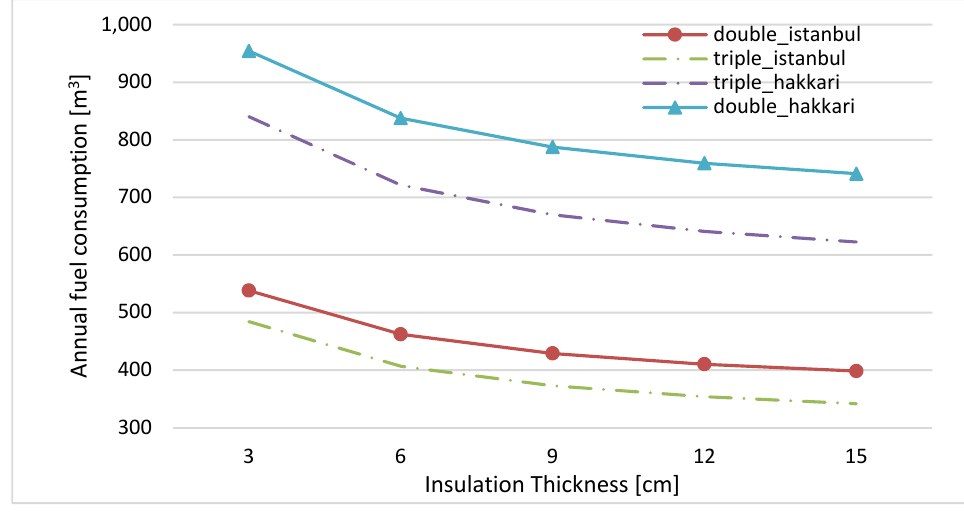
Figure 13. Effect of insulation thickness and window type on fuel consumption .